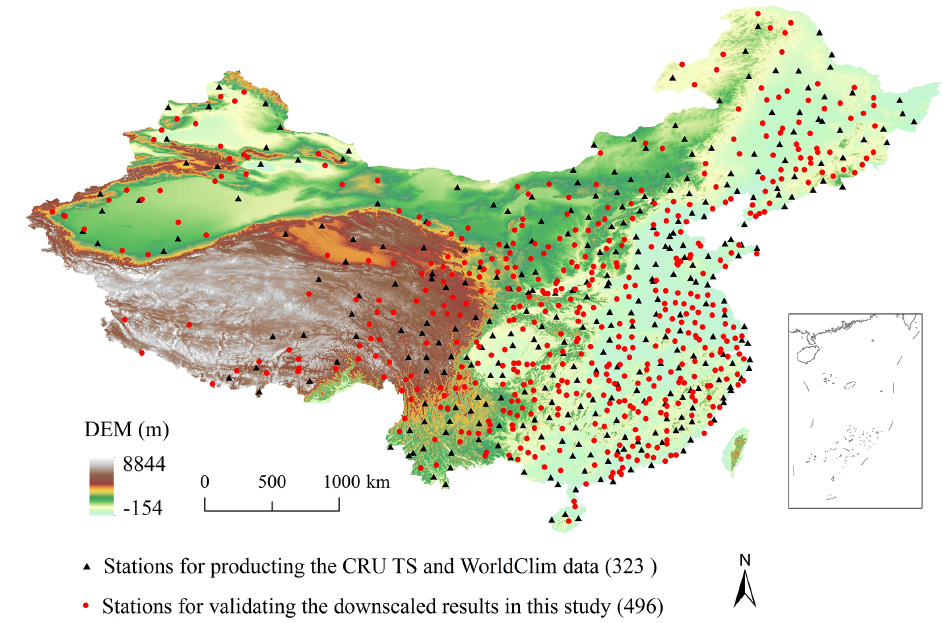
Figure 1. Spatial distribution of national weather stations across China.